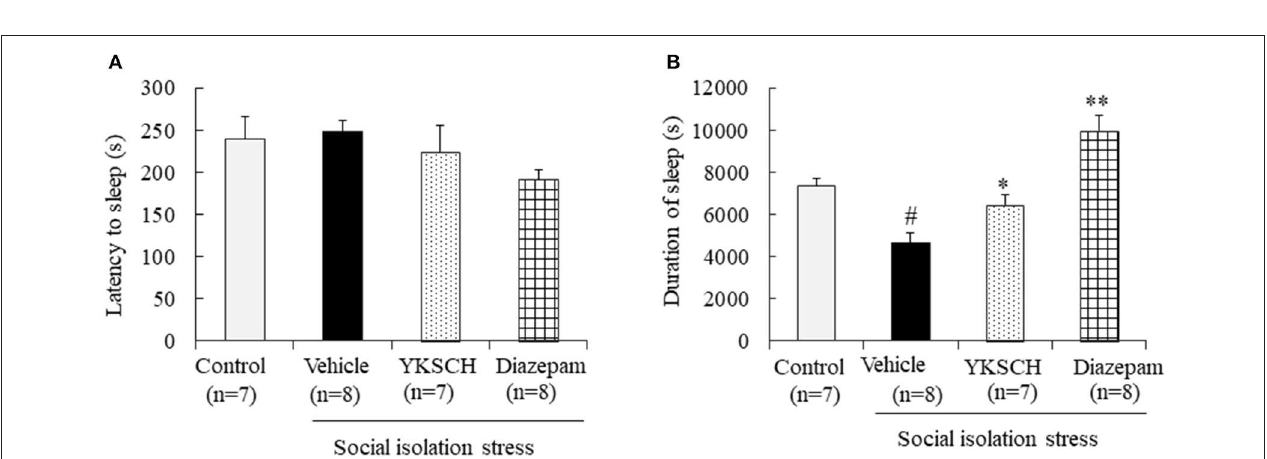
FIGURE 4 | Effect of YKSCH on pentobarbital-induced sleeping behavior in socially isolated mice. Mice were housed individually and treated with YKSCH or vehicle for 4 weeks. One hour after the last injection, mice were treated with pentobarbital. Sleep latency (A) and duration (B) were measured. Diazepam was treated once 1h before pentobarbital injection. Data are expressed as the mean ± SEM ( n = 7–8). # p < 0.05 vs. the control group; * p < 0.05, ** p < 0.01 vs. the vehicle-treated group, Peritz’s F